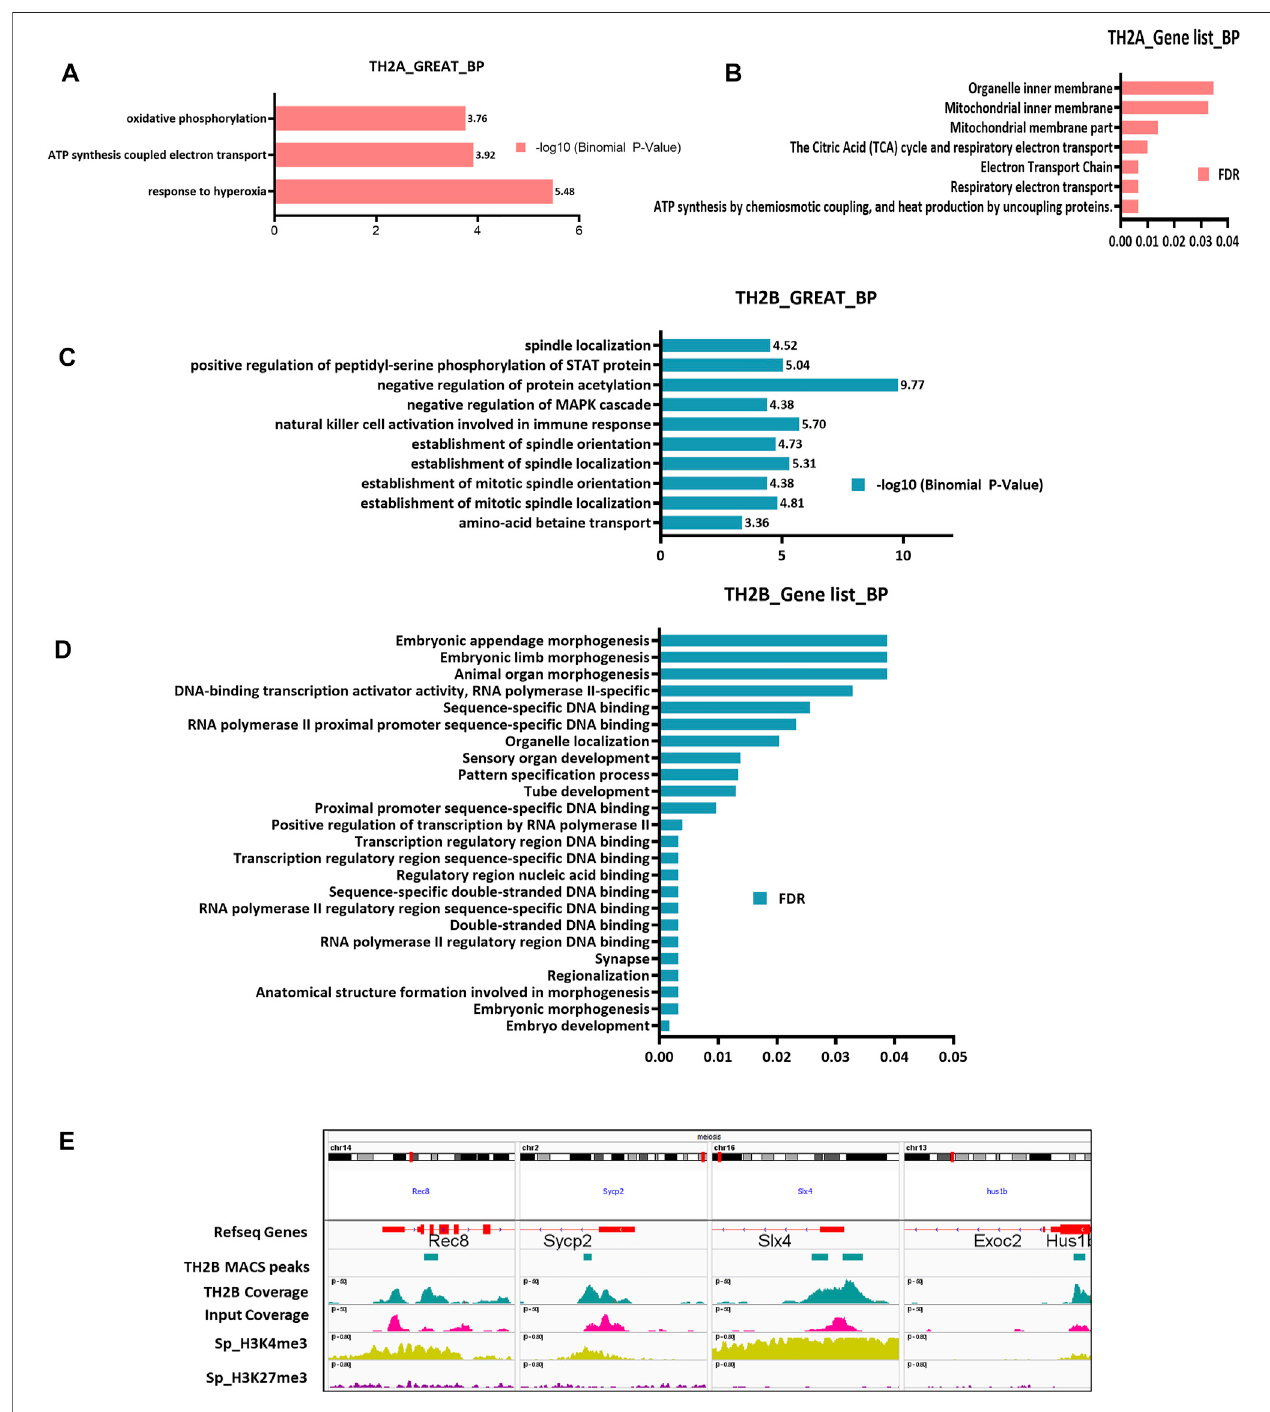
FIGURE 5 | Genomic intervals as well as gene list-based Gene Ontology (GO) enrichment analysis. (A) Genomic region-based Gene Ontology (Biological processes) for TH2A bound chromatin using GREAT tool calculated according to – log10 (Binomial p -value). (B) Gene Ontology-Biological Processes for TH2A- associated genes using GOliath ranked as per the false discovery rate (FDR). (C) Genomic region-based Gene Ontology (Biological processes) for TH2B-bound chromatinusingGREATtoolcalculatedaccordingto – log10(Binomial p -value). (D) GeneOntology-BiologicalProcessesforTH2B-associatedgenesusingGOliath ranked as per the false discovery rate (FDR). (E) IGV view showing TH2B MACS peak at genes important for meiosis — Rec8, Sycp2, Slx4, and Hus1b along with ChIP Atlas bigWig coverage alignment tracks for sperm PTMs H3K4me3 (activating mark) and H3K27me3 (repressive mark).